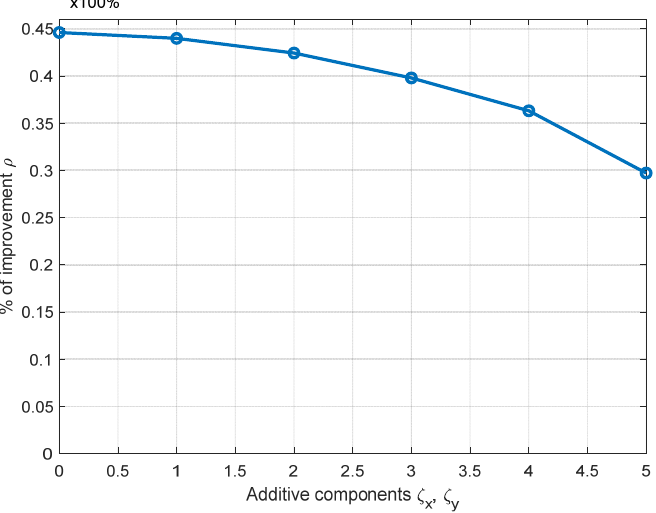
Figure 9. Generalization of the network scenario for evaluation.